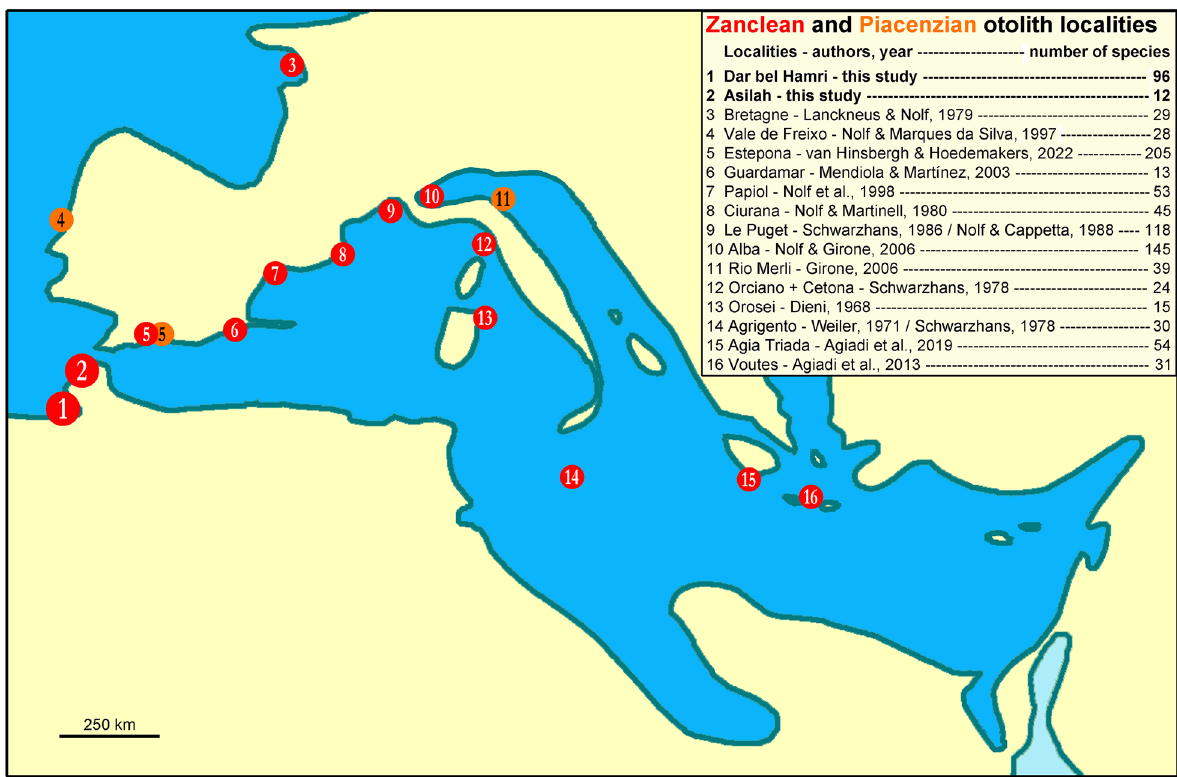
Fig. 30 Early Pliocene paleogeography of the Mediterranean and adjacent northeastern Atlantic. Paleogeographic configuration based on Popov et al., (2004; middle Pliocene map) and Pérez-Asensio (2021). Zanclean locations with otoliths marked by white numbers with red frame, Piacenzian locations with otoliths marked by black numbers with orange frame. Number of species and authors